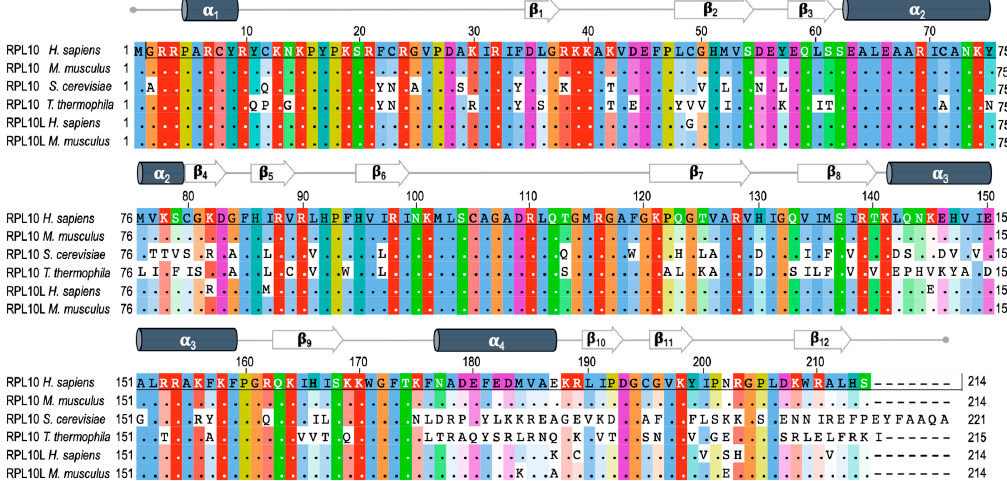
Figure 1. RPL10 and RPL10L (ribosomal protein L10-like gene) protein sequence alignment. The